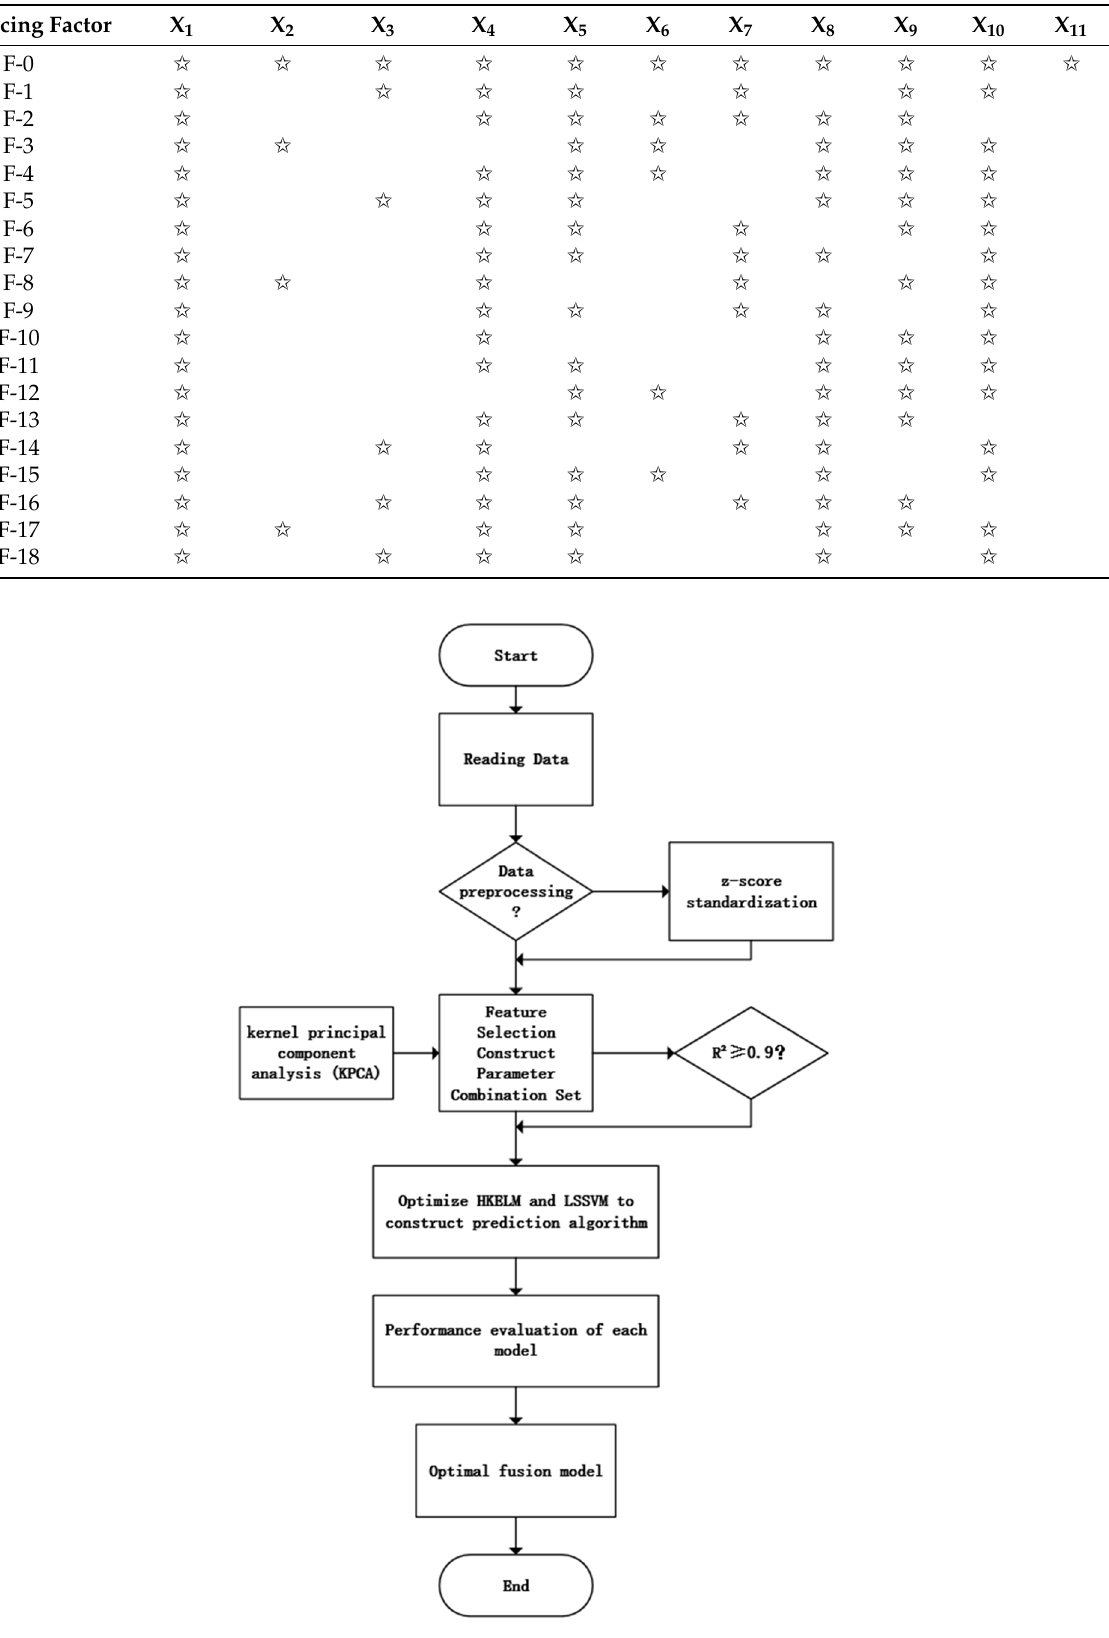
Table 2. Gas emission characteristic parameter set.